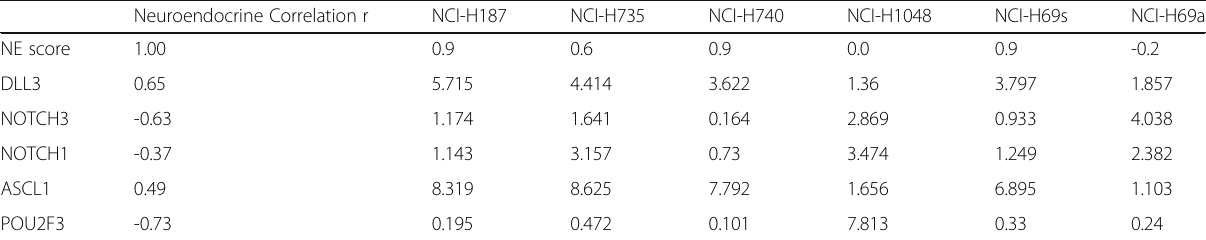
Table 1 Expression of neuroendocrine markers in SCLC cell